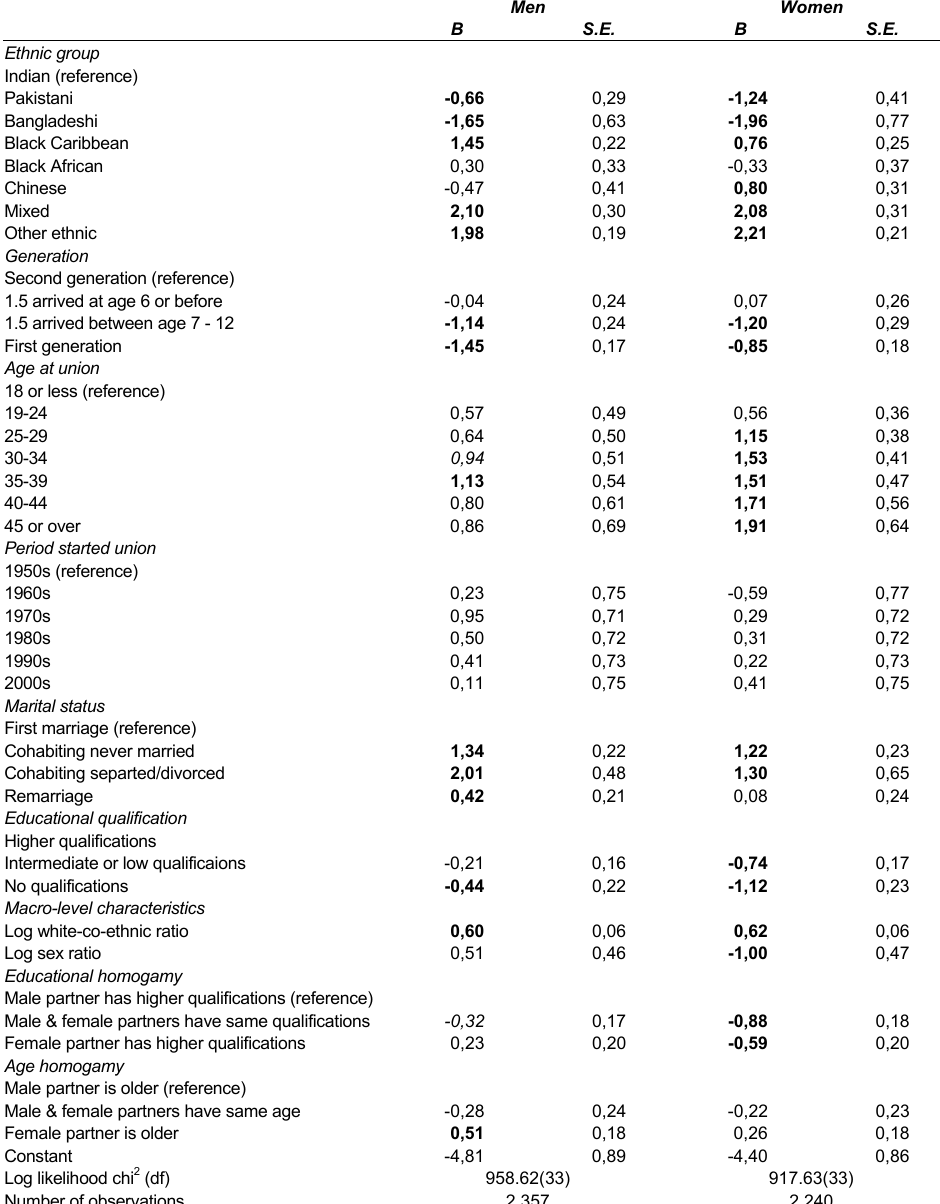
Table 3: Logistic regression estimates of probability of interethnic union with a White British partner for ethnic minority men and women Men Women B S.E. B S.E. Ethnic group Indian (reference)